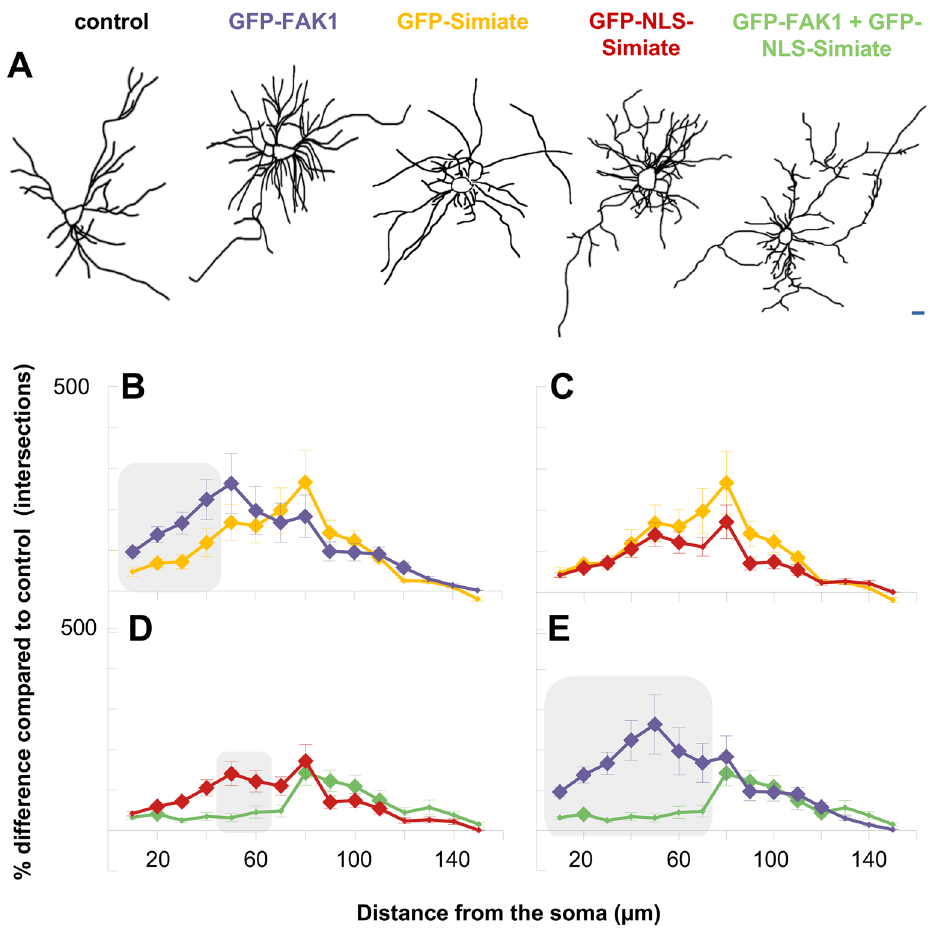
Figure 8. FAK1 and Simiate function together in dendritogenesis. ( A ) Dendritic trees experience different degrees of complexity after over-night expression of recombinant FAK1 and Simiate. Neurons expressing the indicated constructs were processed in Fiji software for Sholl analyses based on MAP2 staining and GFP signal. ( B – E ) Results from Sholl analyses are shown as percentage difference to GFP expression (control). Significant changes to control conditions are indicated by big rhombs, whereas significant differences between constructs are displayed by grey boxes. Small rhombs indicate no significant difference from control, as for instance seen with Simiate constructs (yellow and red lines) beyond 120 µm or in the co-expression experiments (green lines) around 50 µm. Scale bar: 10 µm. GFP: n = 20; FAK1: n = 21; Simiate: n = 21; NLS-Simiate: n = 21; FAK1 + NLS- Simiate: n = 18. For more statistical details, please see Suppl. Table